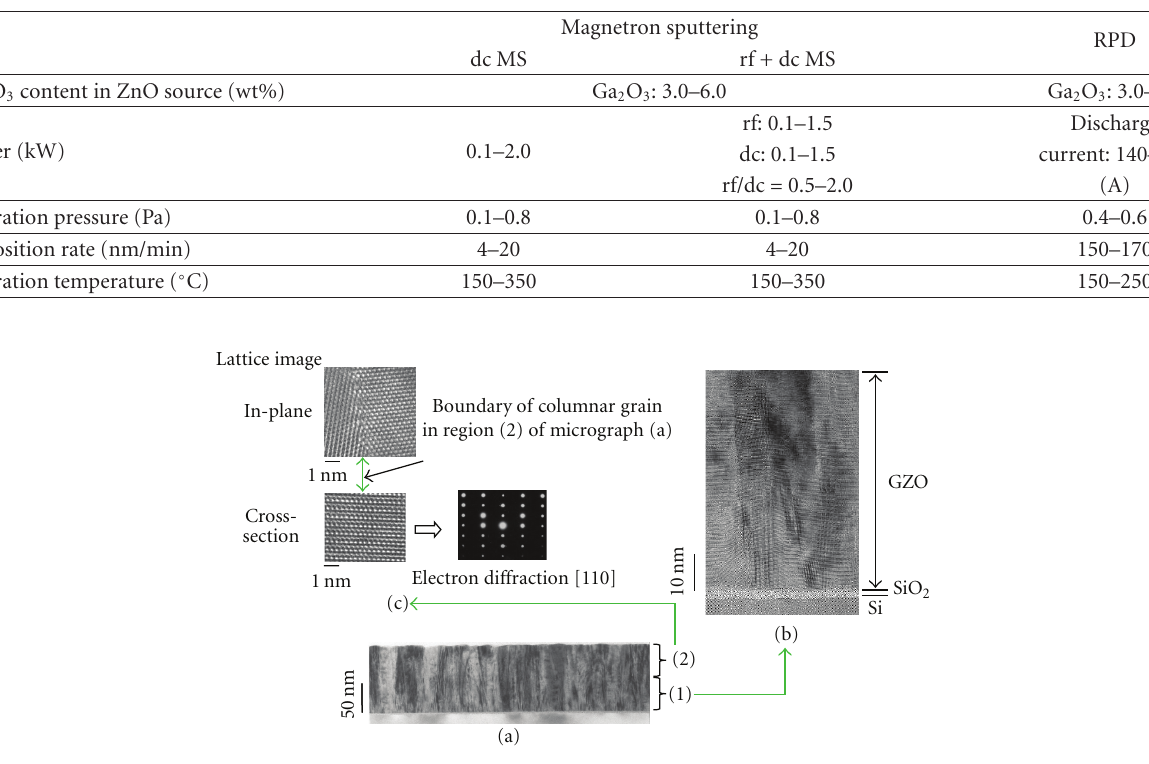
Figure 1: (a) Cross-sectional TEM micrograph of a GZO film. (b) Close-up view of a region in the vicinity of the film-substrate interface (region (1) in (a)). The layered structure in a GZO film with a Wurtzite structure, enhanced using Photoshop Elements 3.0 software (Adobe Systems Inc.). (c) Lattice image and electron di ff raction pattern observed by TEM in the vicinity of the surface of the film (region (2) in (a)).